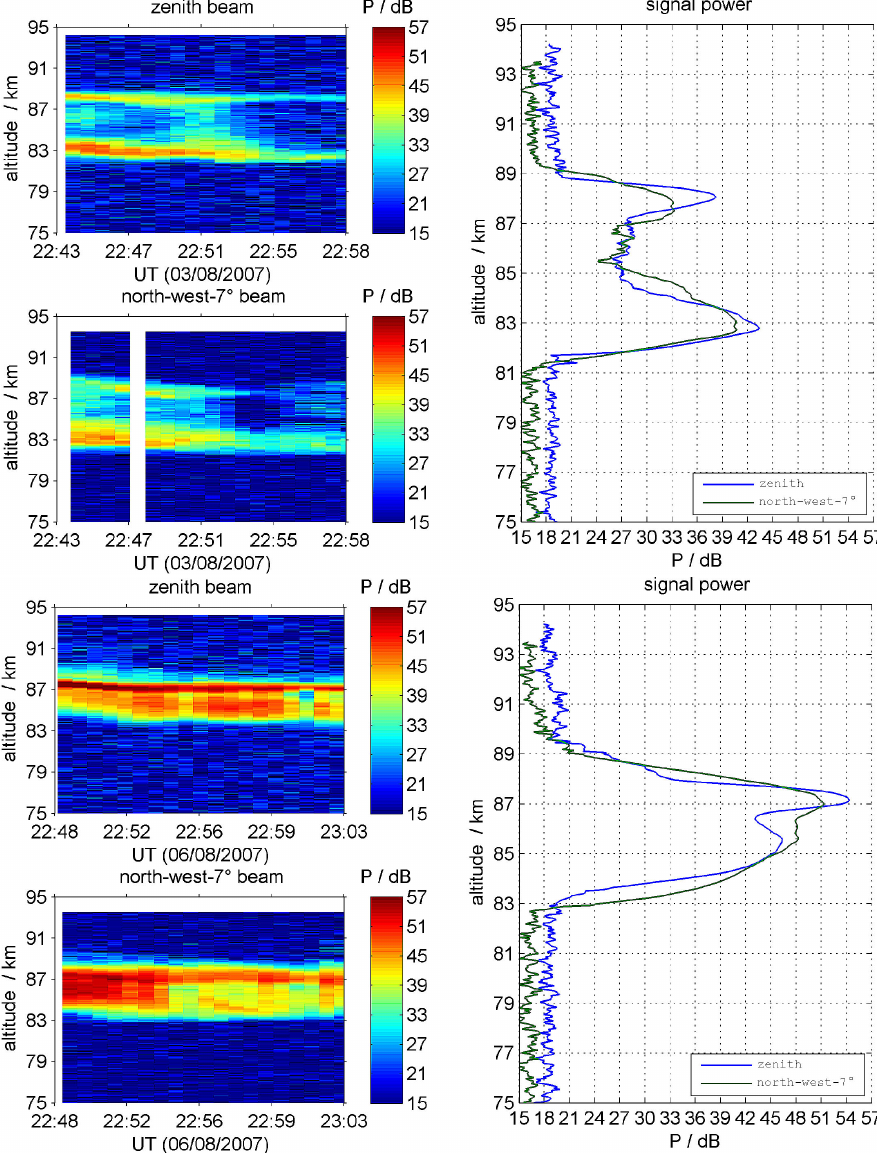
Fig. 3. Upper panel: ALWIN radar data for the 15min period nearest the launch of MASS1. Lower panel: ALWIN radar data for the 15min period nearest the launch of